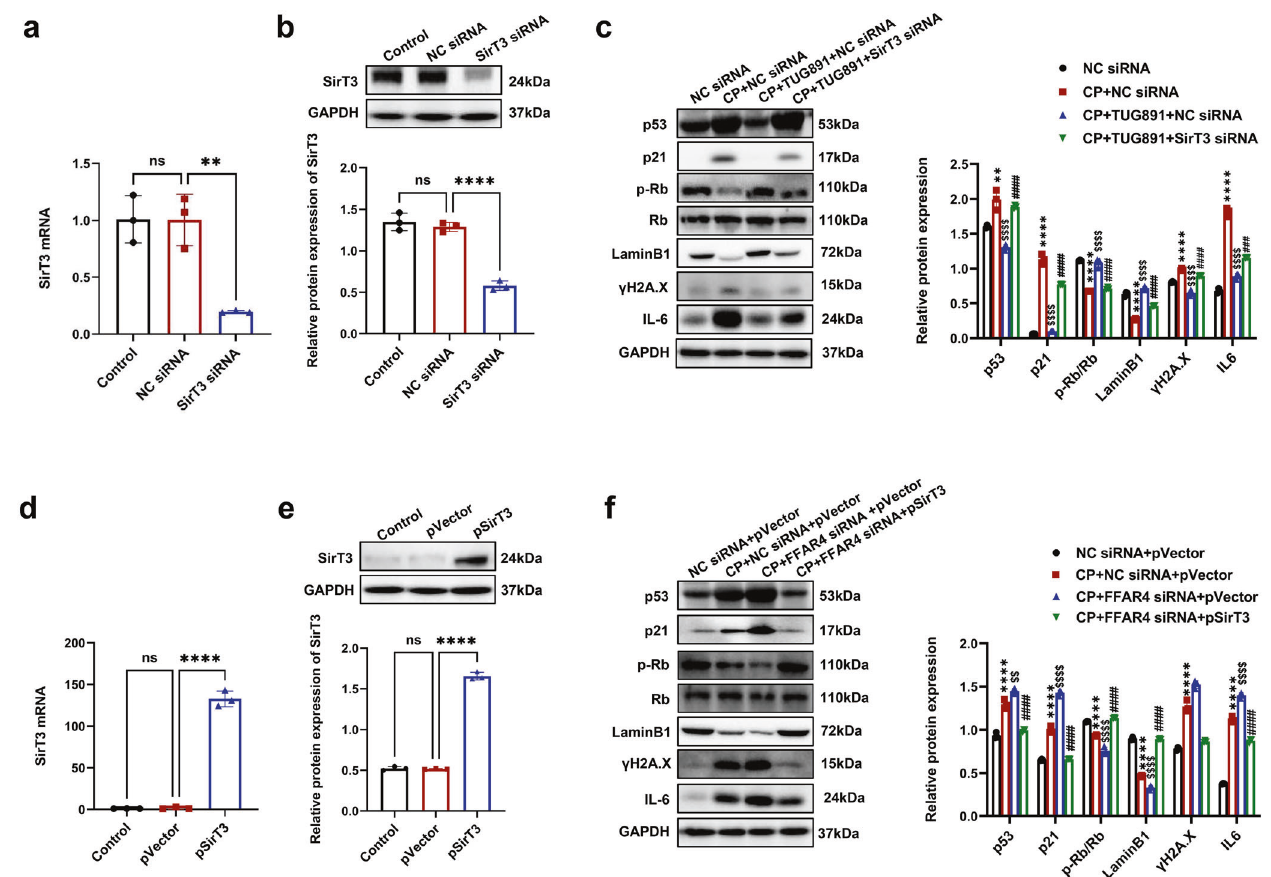
Fig. 8 FFAR4 suppressing cisplatin-induced senescence via activating SirT3 in AKI mice. a , b Relative mRNA and protein expression of SirT3 in TCMK-1 cells transfected with SirT3 siRNA ( n = 3; **** P < 0.001, * P < 0.05, ns. no signi fi cant). c Protein expression of p53, p21, LaminB1, p-Rb/Rb, ɣ H2A.X and IL-6 in TCMK-1 cells transfected with SirT3 siRNA detected by western blotting and quanti fi ed by densitometry ( n = 3; **** P < 0.0001, ** P < 0.01, CP + NC siRNA vs . NC siRNA; $$$$ P < 0.0001, CP + TUG891 + NC siRNA vs . CP + NC siRNA; #### P < 0.0001, ### P < 0.001, CP + TUG891 + FFAR4 siRNA vs. CP + TUG891 + NC siRNA). d , e Relative mRNA and protein expression of SirT3 in TCMK-1 cells transfected with transfected with empty plasmid (pVector) or plasmid expressing SirT3 (pSirT3) ( n = 3; **** P < 0.001, ns no signi fi cant). f Protein expression of p53, p21, LaminB1, p-Rb/Rb, ɣ H2A.X and IL-6 in TCMK-1 cells trans f ected with empty plasmid (pVector) or plasmid expressing SirT3 (pSirT3) detected by western blotting and quanti fi ed by densitometry ( n = 3; **** P < 0.0001, CP + NC siRNA + pVector vs. NC siRNA + pVector;